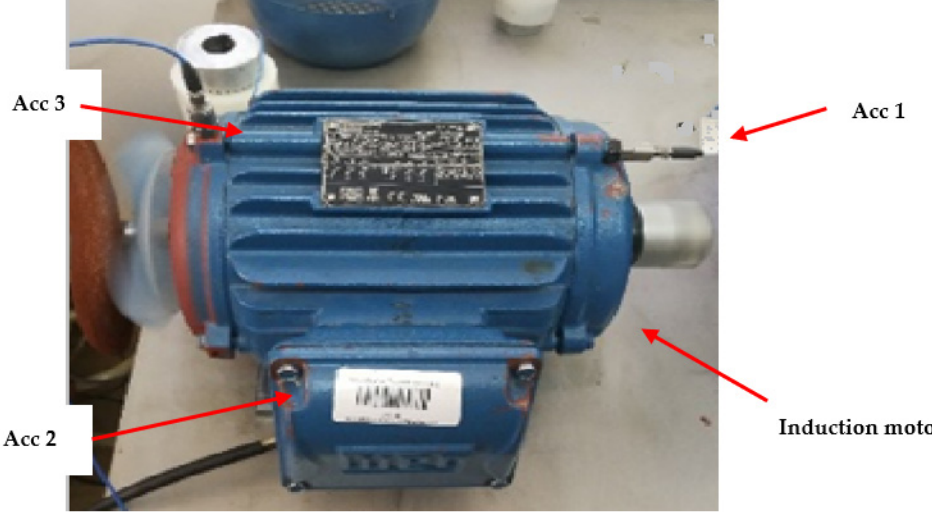
Figure 4. OMA’s measurement set up for the induction motor with mounted accelerometers.